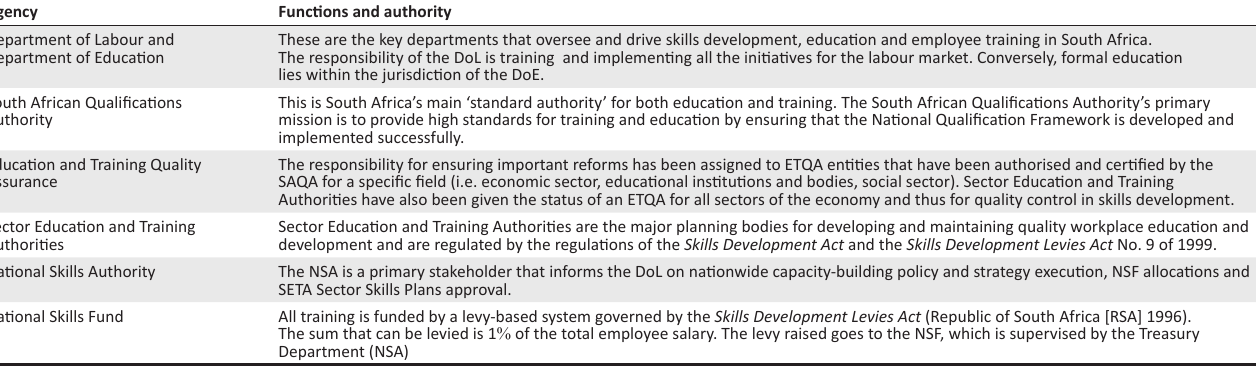
TABLE 1: Skills implementation agencies and their functions.